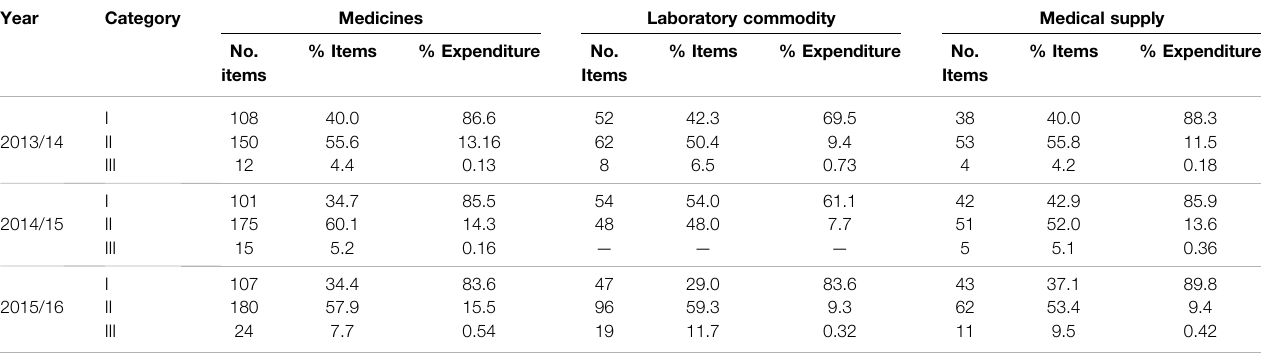
TABLE 3 | ABC-VEN matrix analysis of medicines at SPHMMC for 2013/14 – 2015/16.